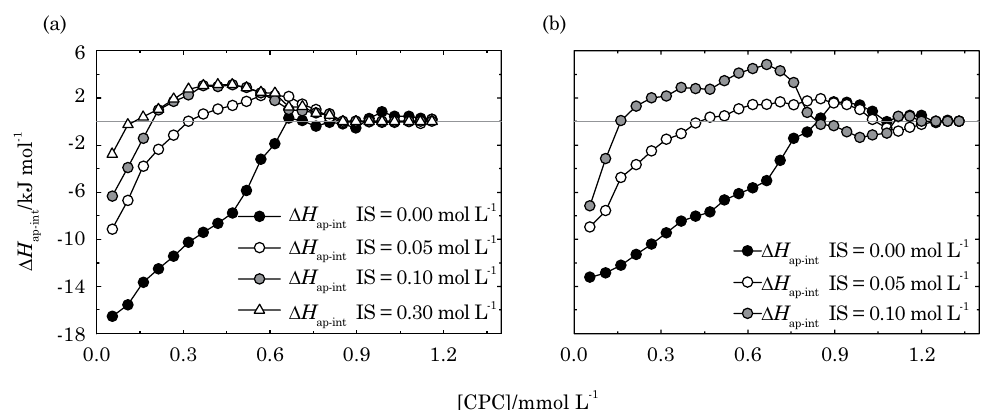
Figure 4. Apparent molar enthalpy change (∆ H ap-int ) of the interaction between elliott soil (a) and Pahokee peat (b) humic acids (eSha and PPha) and hexadecylpyridinium chloride monohydrate (cPc) surfactant in carbonate buffer at 25 o c and increasing ionic strength